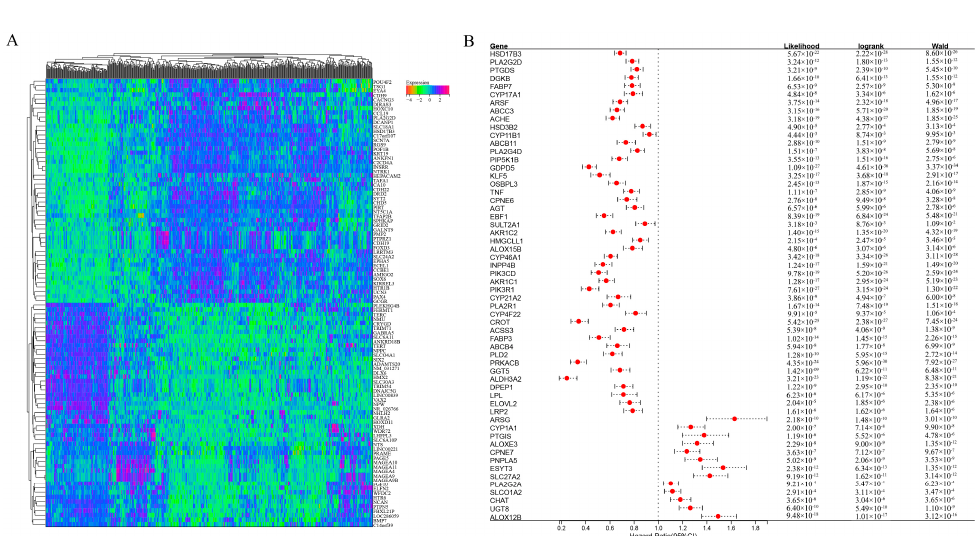
Figure A1. ( A ) Gene expression heatmap of Top–100 (up– and down–regulated) differentially expressed genes. ( B ) Prognostic survival analysis of 58 genes.